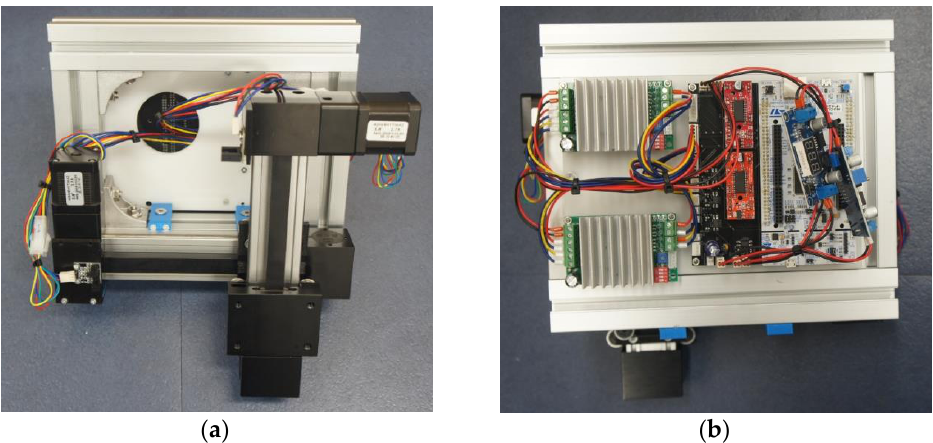
Figure 8. Multi-layer mechanical unit with a vertically arranged structure (side view).